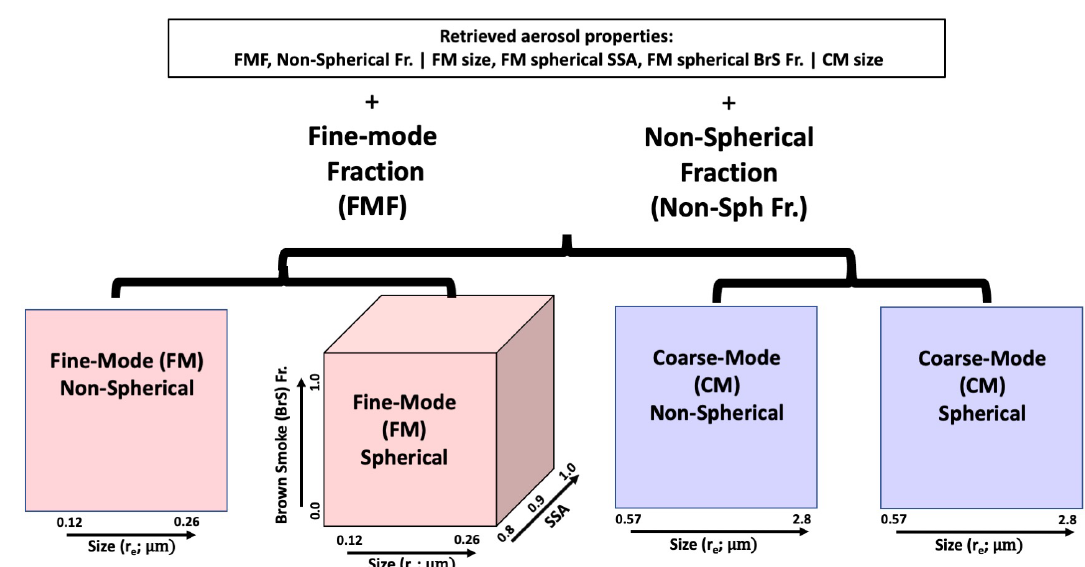
Figure 1. The pink square on the left shows the bins corresponding to our fine-mode (FM) non-spherical aerosol models; the pink cube in the center left demonstrates how our 10 fine-mode spherical components are organized onto a rectangular grid. The center right blue square shows the two size bins for the coarse-mode non-spherical components, whereas the blue square on the right shows the same two size bins for our coarse-mode spherical components. These four discretized grids are then used to additionally retrieve the fine-mode fraction (FMF) and non-spherical fraction (both at